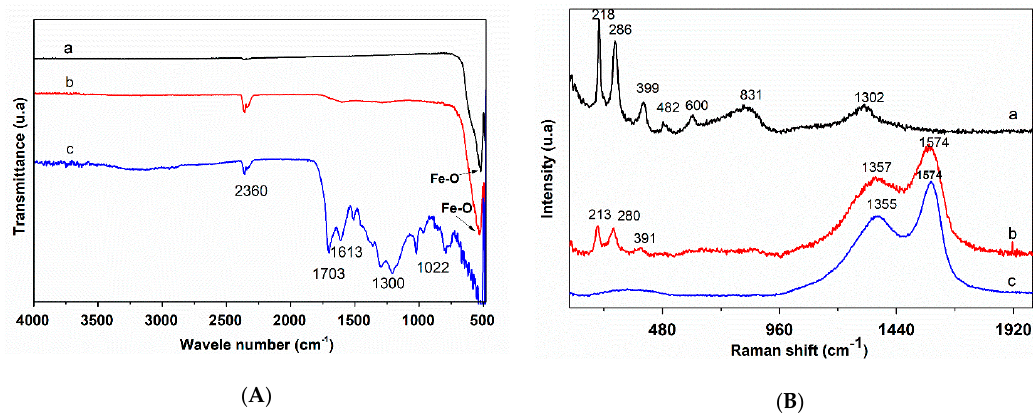
Figure 2. ( A ) Fourier transform infrared (FTIR) spectra of: (a) commercial hematite, (b) Fe 2 O 3 -CMS, (c) CMS, ( B ) Raman spectra of: (a) commercial hematite, (b) α -Fe 2 O 3 -CMS, (c) CMS.